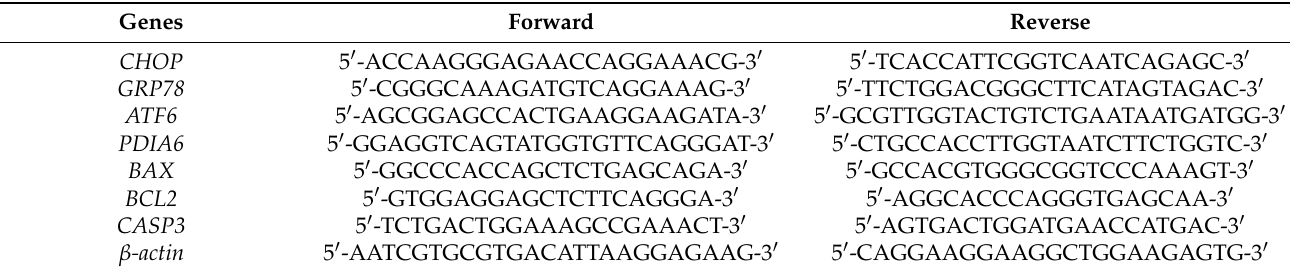
Table 2. Primers used for the target and reference